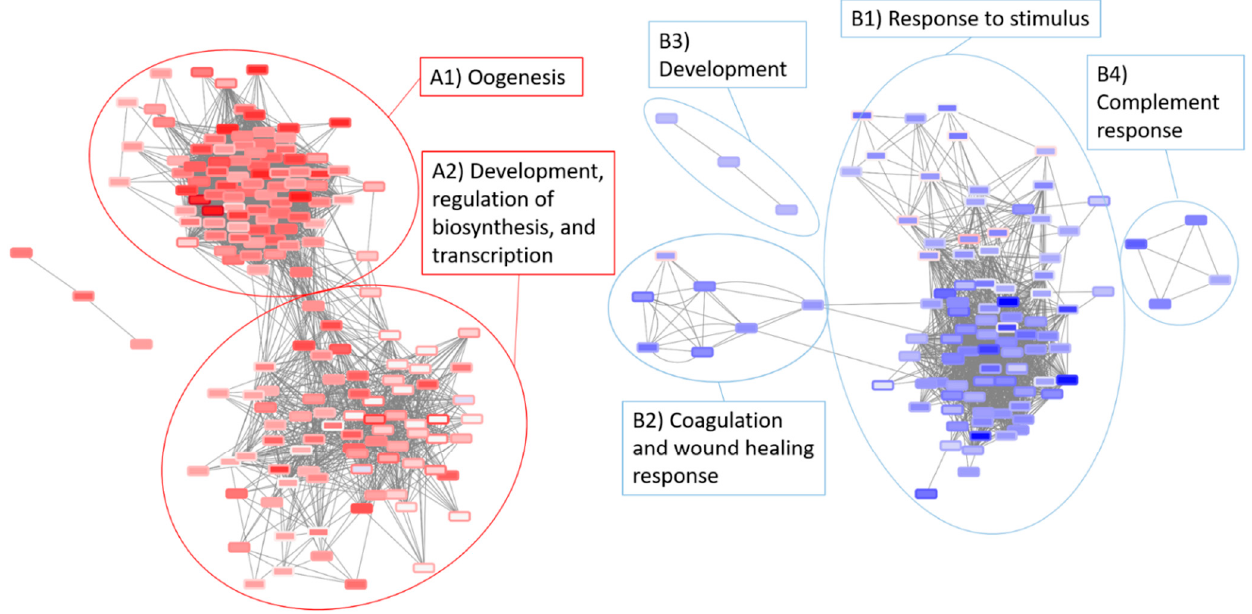
Figure 10. Integrated networks of the radiation (28.5-rad) and the torpor+radation group (18.5-mel-rad) generated by NetNC analysis. Fold change values for the radiation group are shown by node fill colour, values for torpor + radiation are represented by the shape border colour. Node shapes indicate: NetNC-predicted coherent genes in both groups (rectangular), in the radiation group only (oval), in the torpor + radiation group only (diamond) and changed in opposite directions (triangular). Results from each condition show very substantial overlap, with some notable differences being the upregulation of genes in the torpor + radiation group (18.5-mel-rad vs. 28.5-Ctrl) that confer radio-resistance ( TXN , GSTP1 ) and promote survival ( HMGB1